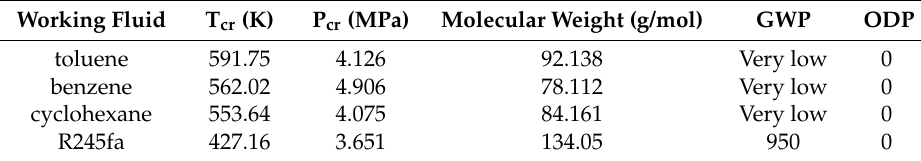
Table 3. Properties of the working fluids.